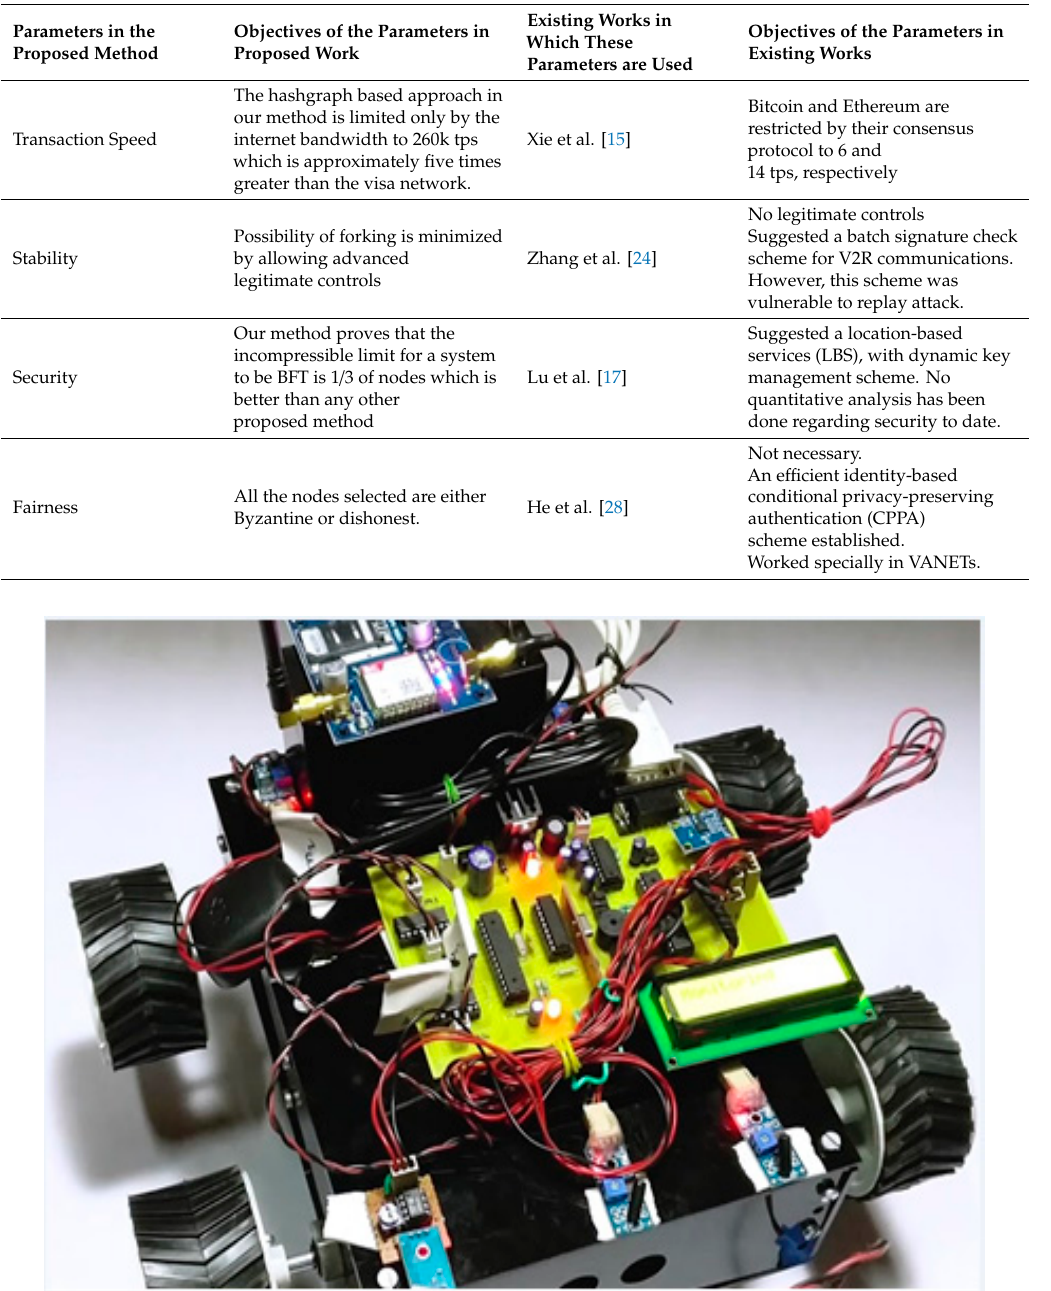
Table 1. Comparative analysis between our proposed work with previously published work.